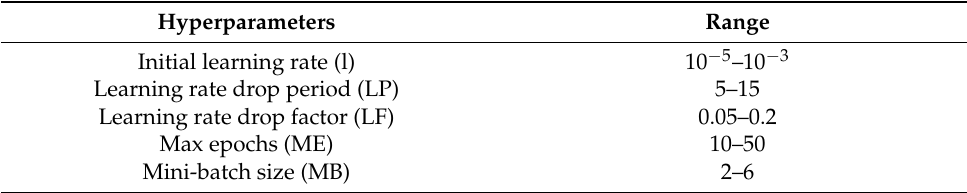
Table 1. Experiment